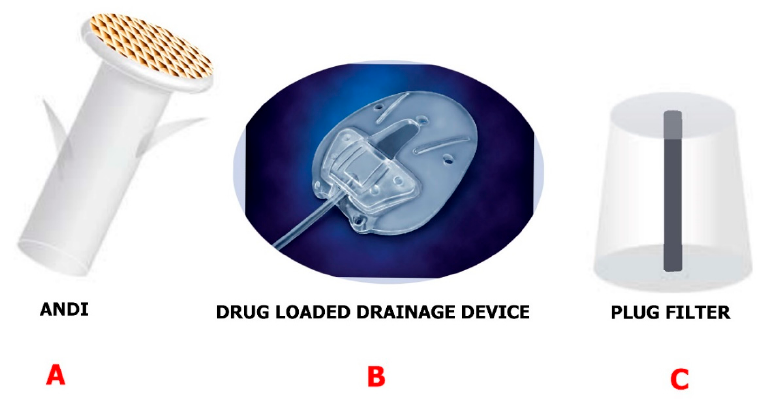
Figure 8. Examples of drainage devices engineered using nanotechnology approaches. ( A ) The ANDI is implanted in the sclera. Reproduced from [101] with permission from IEEE. ( B ) Drug-loaded drainage devices are manufactured with a film layer loaded with drug for continuous release. Reproduced from [99] with permission from Elsevier. ( C ) The plug filter is manufactured with a biodegradable polymer to eliminate postoperative hypotony. Reproduced from [103] with permission from